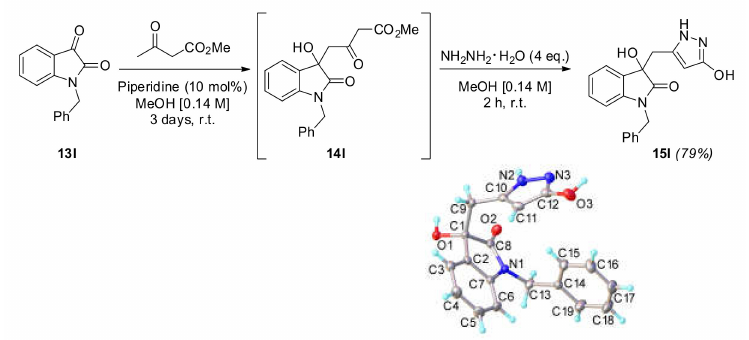
Scheme 4. Methodology applied to the N -benzyl-protected isatin 13l . The X-ray structure of 15l is also pictured, where the pyrazole is in its enol form.